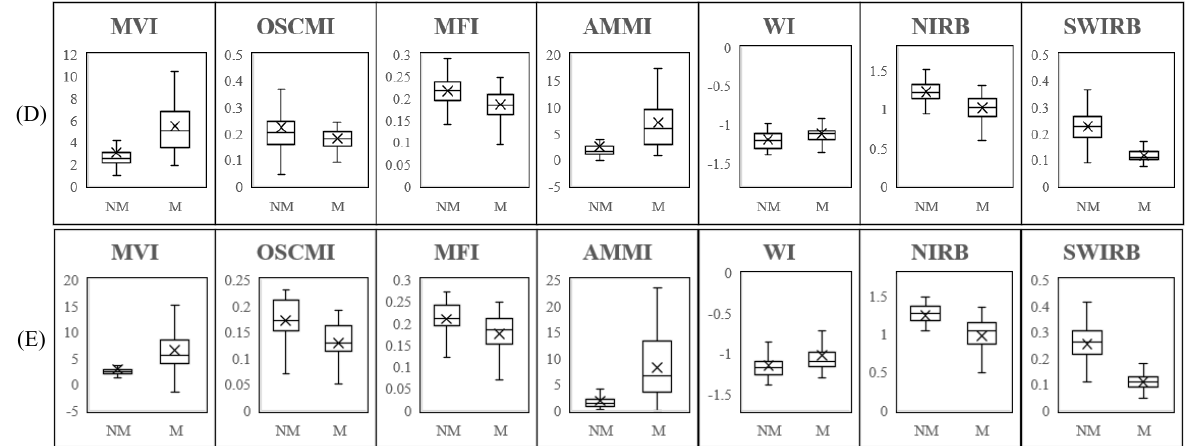
Figure 4. Box plots of the mangrove indices’ values from the validation data for each study area. (A) Puerto Princesa City, Palawan, Philippines; (B) Busuanga, Palawan, Philippines; (C) Siargao Island, Surigao del Norte, Philippines; (D) Select municipalities of